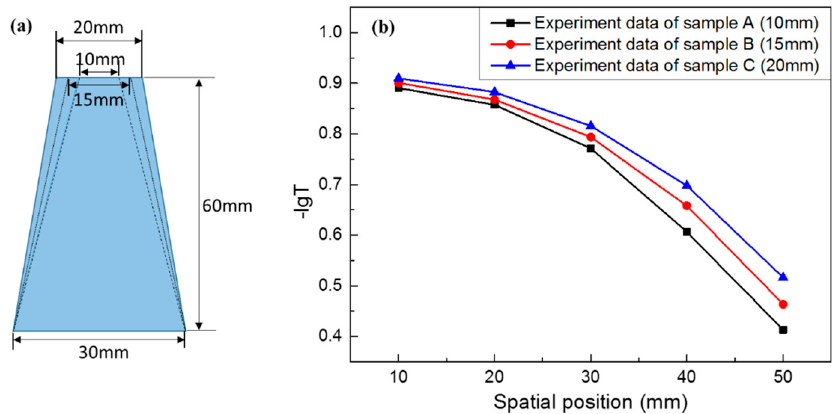
Figure 6. ( a ) Three different trapezoid-shaped samples with top line dimensions of (A) 10 mm, (B) 15 mm and (C) 20 mm; ( b ) transmittance at the central line for stretched composite films A, B and C along their stretching directions at intervals of 10 mm; the inset shows a diagram of the stretched sample.